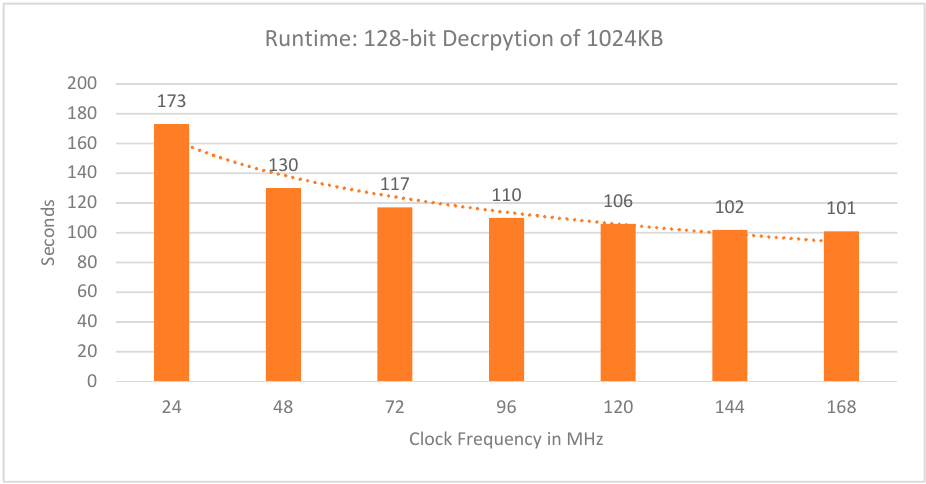
Figure A1. Time to complete decryption with various clock frequency.